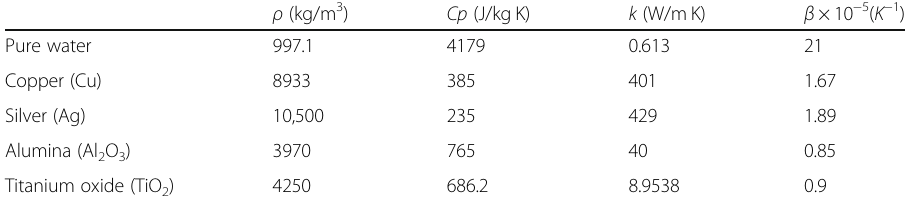
ρ (kg/m 3 ) Cp (J/kg